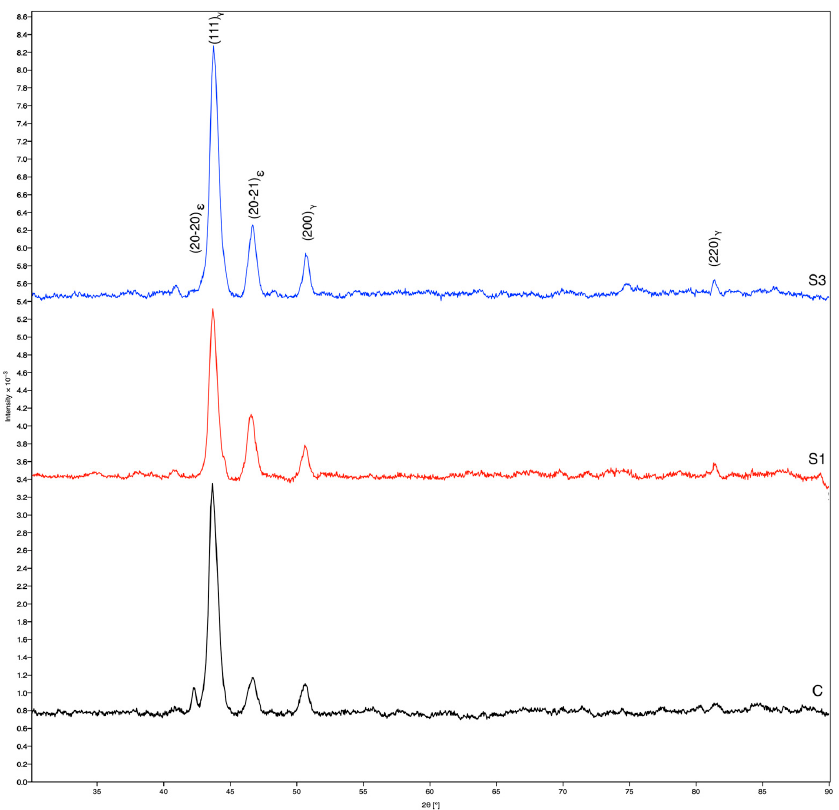
Figure 5. XRD spectra of samples: C, S1 and S3.